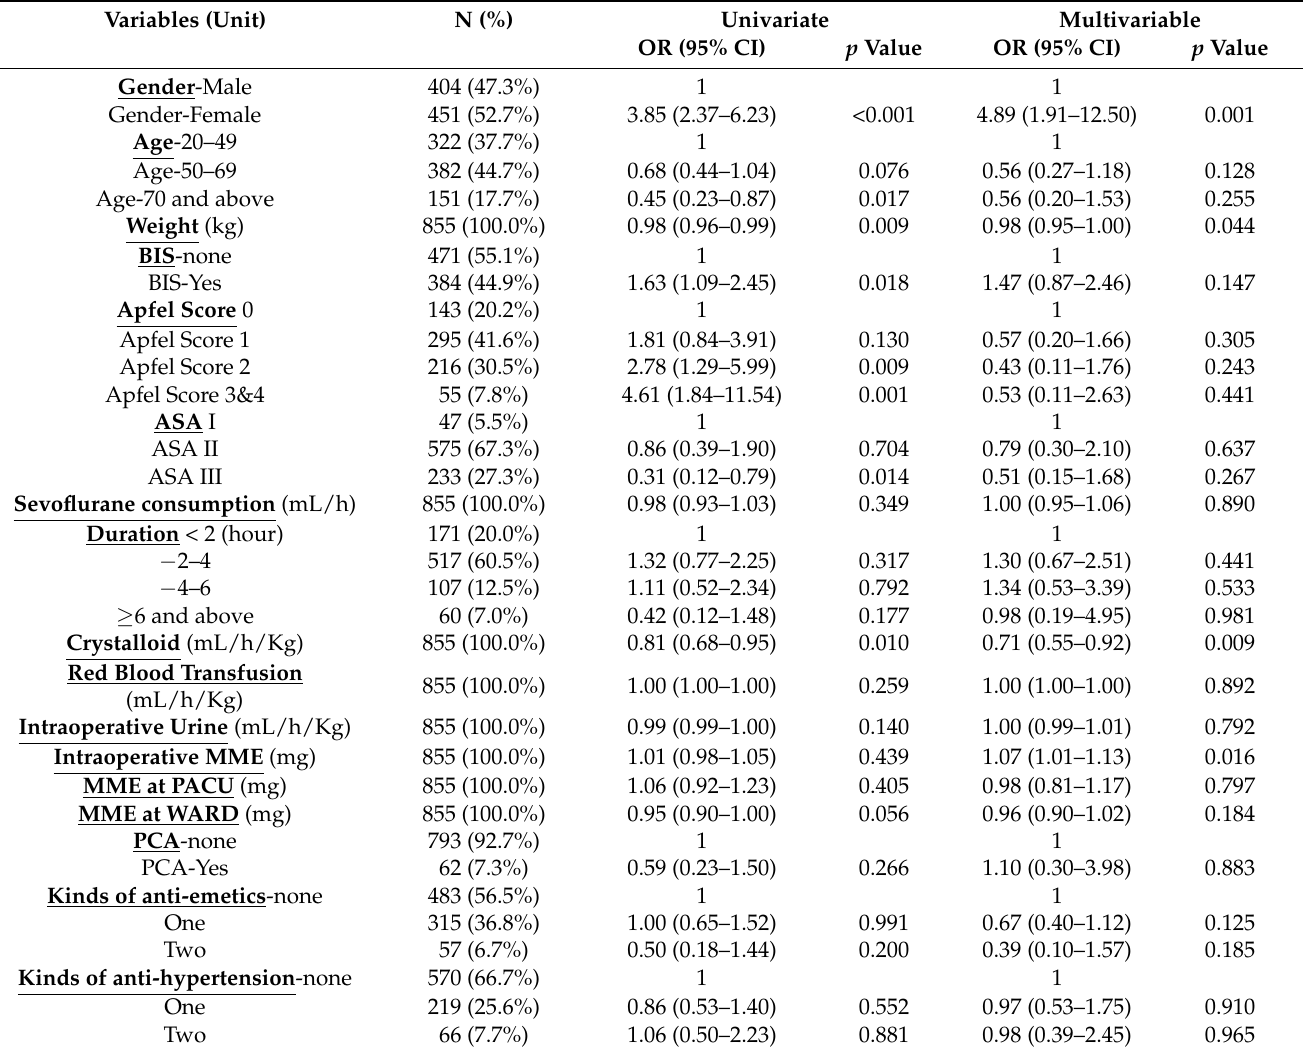
Table 2. Univariate and multiple logistic regression model of postoperative vomiting.